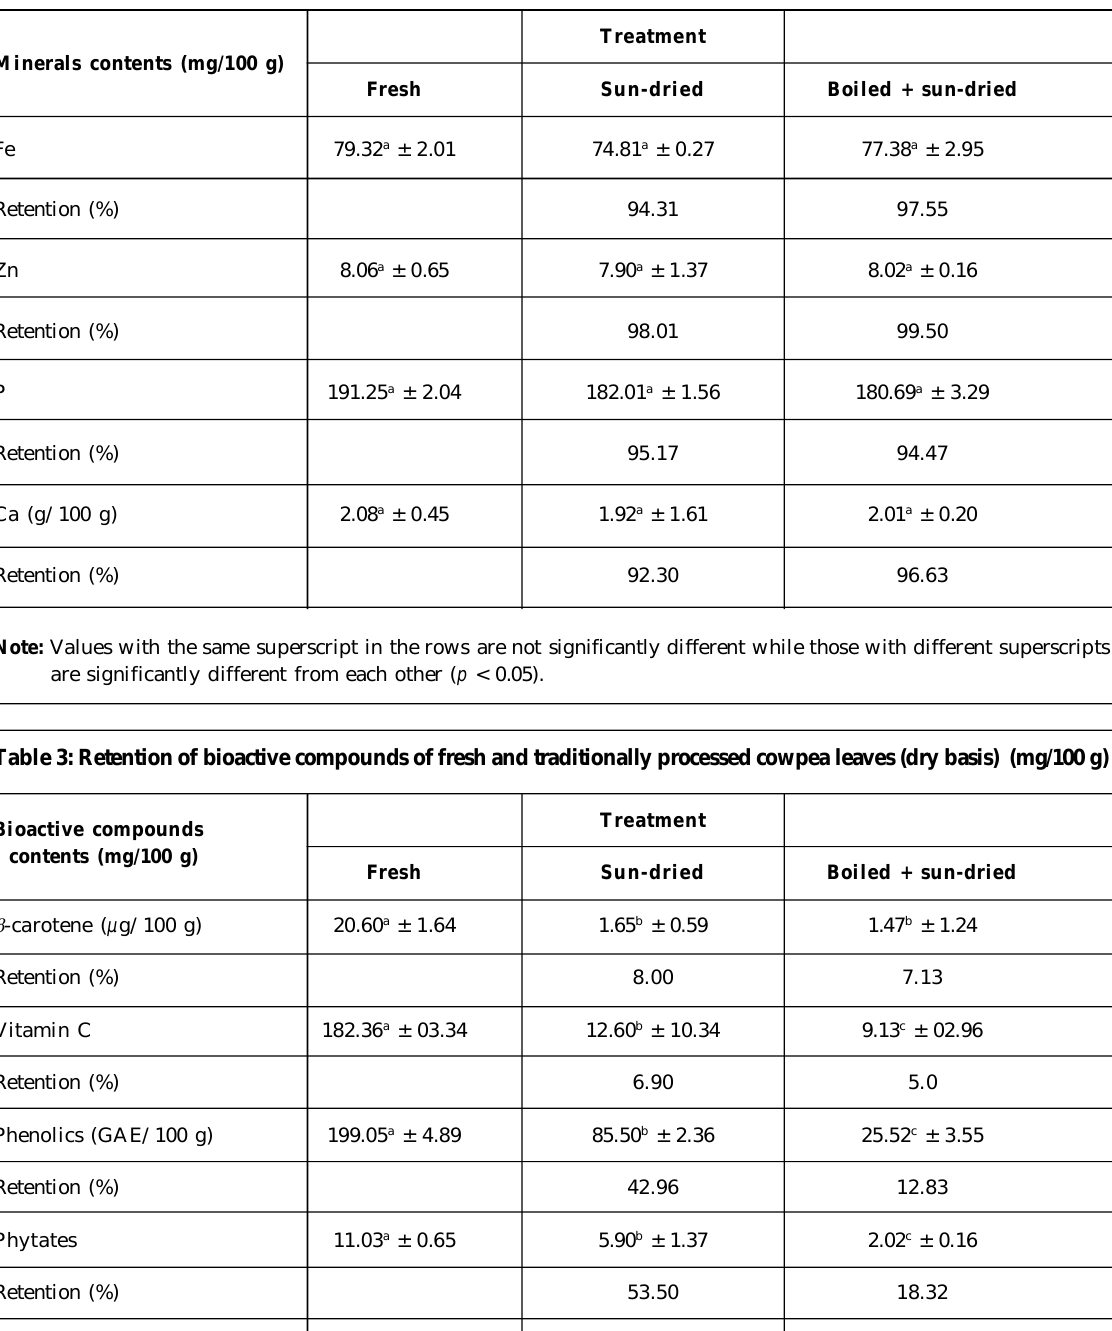
Table 2: Retention of minerals contents of fresh and traditionally processed cowpea leaves (dry basis) (mg/100 g)